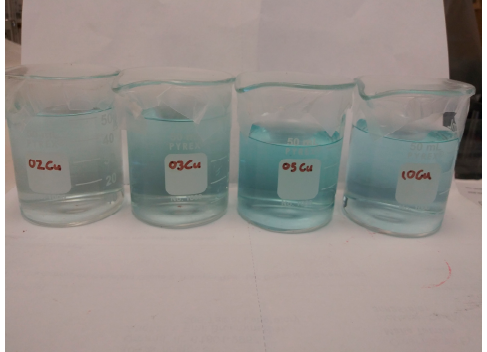
Figure A1. Photograph of samples with 100 ppm Cu with 2, 3, 5, and 10 times as many moles of Bipy added respectively, from left to right in HNO 3 solution.